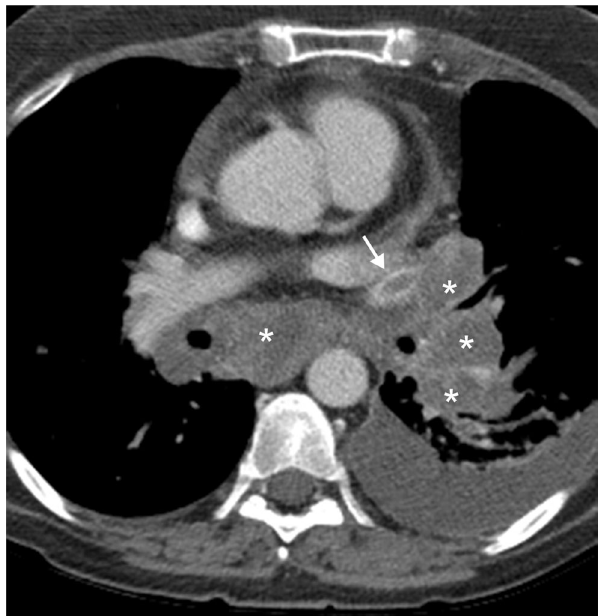
Fig. 15 Pulmonary venous thrombus. Axial contrast-enhanced CTimage in a patient with non-small cell lung cancer demonstrating a filling defect within the left superior pulmonary vein ( white arrow ). Note extensive lymphadenopathy within the left hila and mediastinum (*) from metasta- tic involvement